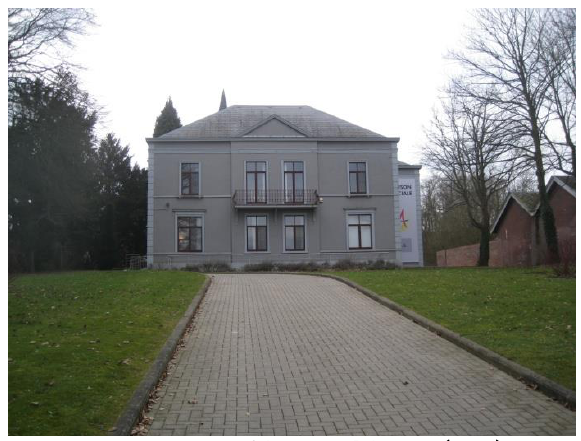
Figure 3: House of the general director (1844)